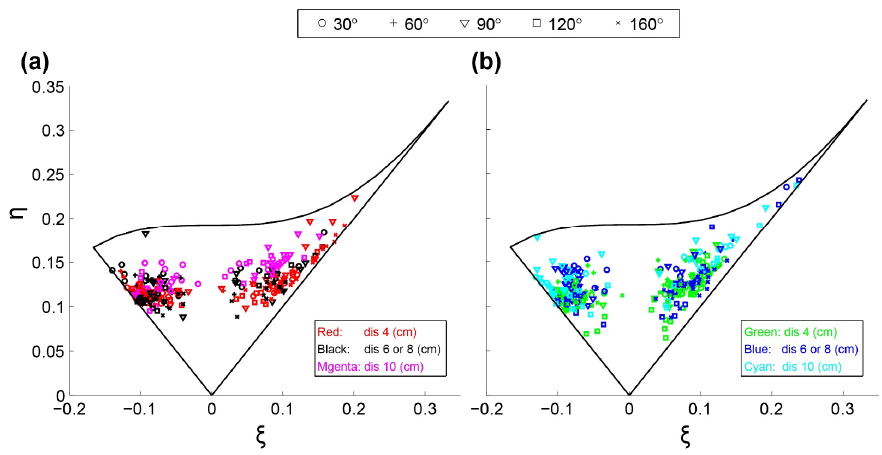
Figure 19. Turbulence triangle plotted in the ξ − η plane at specified azimuthal sections in the case ( a ) without vegetation in the bed and ( b ) with vegetation in the bed, at radial distances from the abutment.